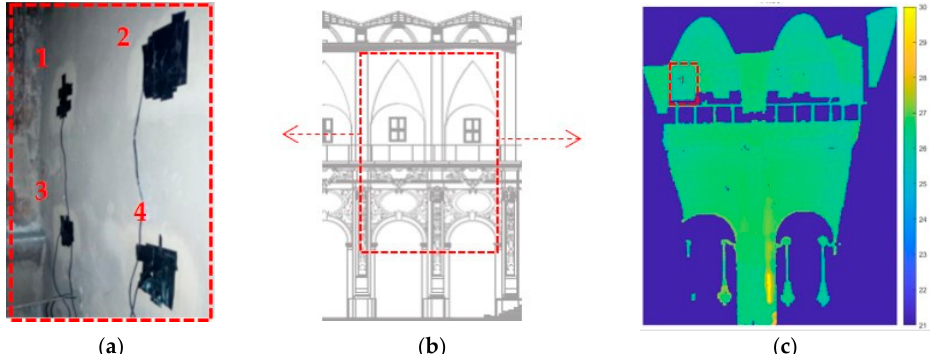
Figure 4. ( a ) Photograph and ( b ) map showing the location of point surface sensors on the north face of Zone 2 at 10 a.m. on 17 September 2019, and those at 10 a.m. on 18 September 2019. ( c ) Location of the same area is indicated on a thermal orthoimage of the lateral wall.